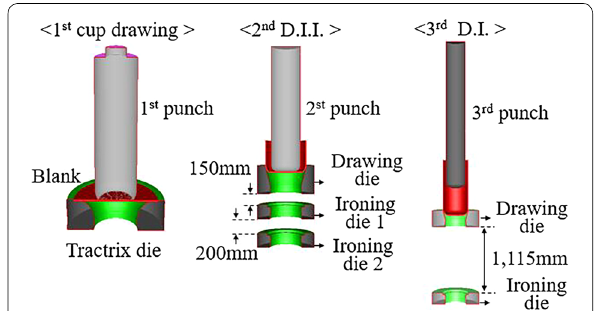
Figure 8 Analysis models in the D.D.I.